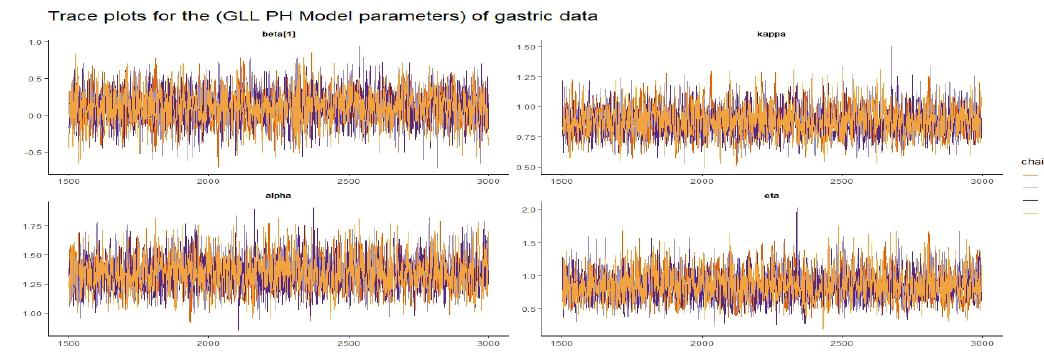
Figure 3. The GLL–AH model posterior parameters trace plots of the gastric cancer data.